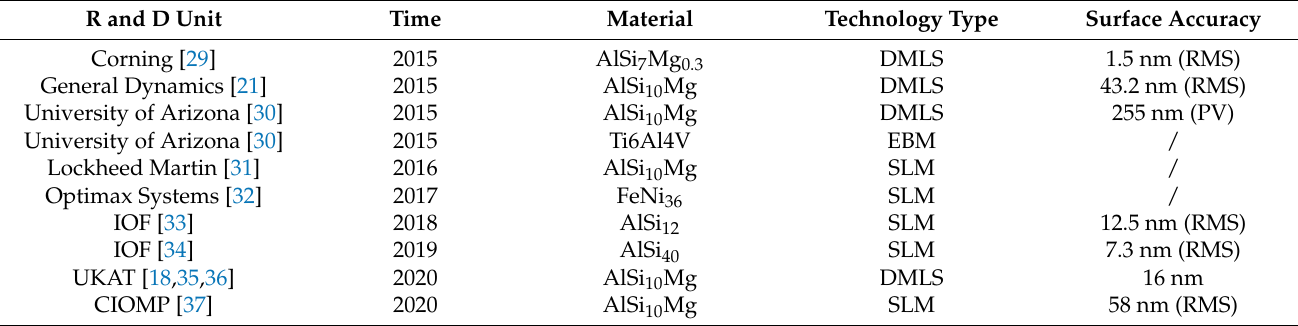
Figure 7. Schematic diagram of SLS.